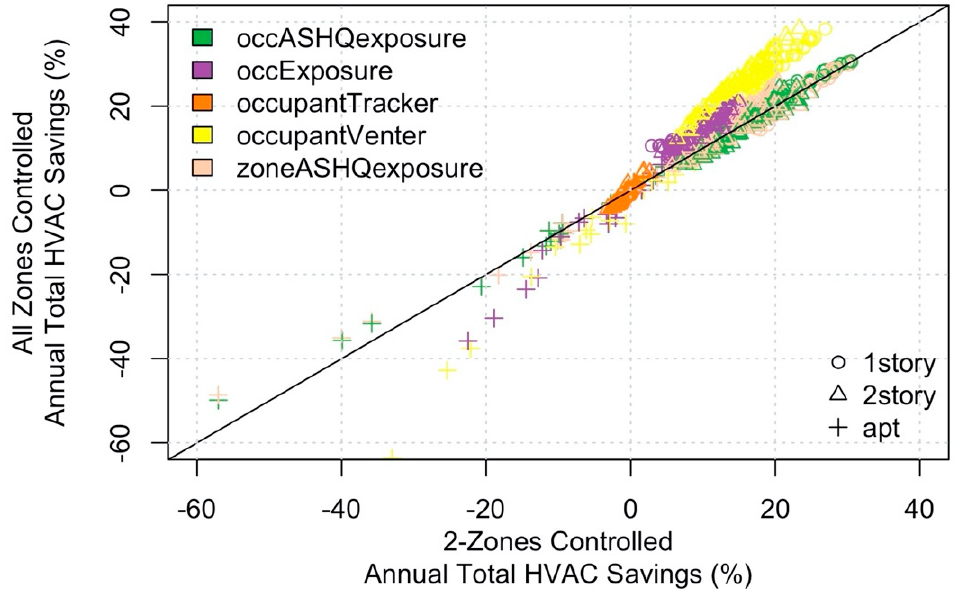
Figure 6. Comparison of energy use for systems controlling all zones or only two zones for different control strategies (colours) and dwelling types (symbols).